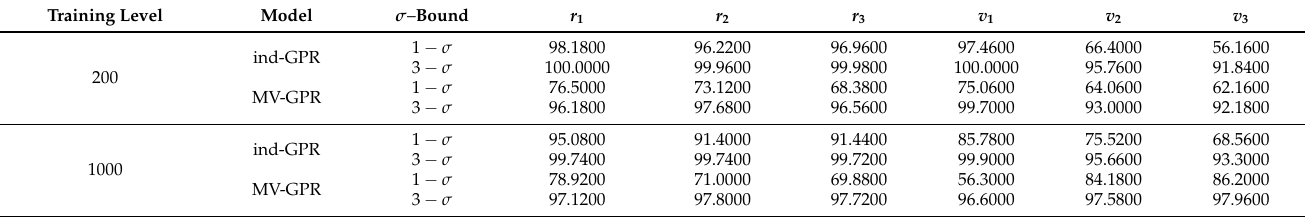
Table 5. Percentage of errors within σ –bound for ind- and MV-GPR given perfect input measurements.